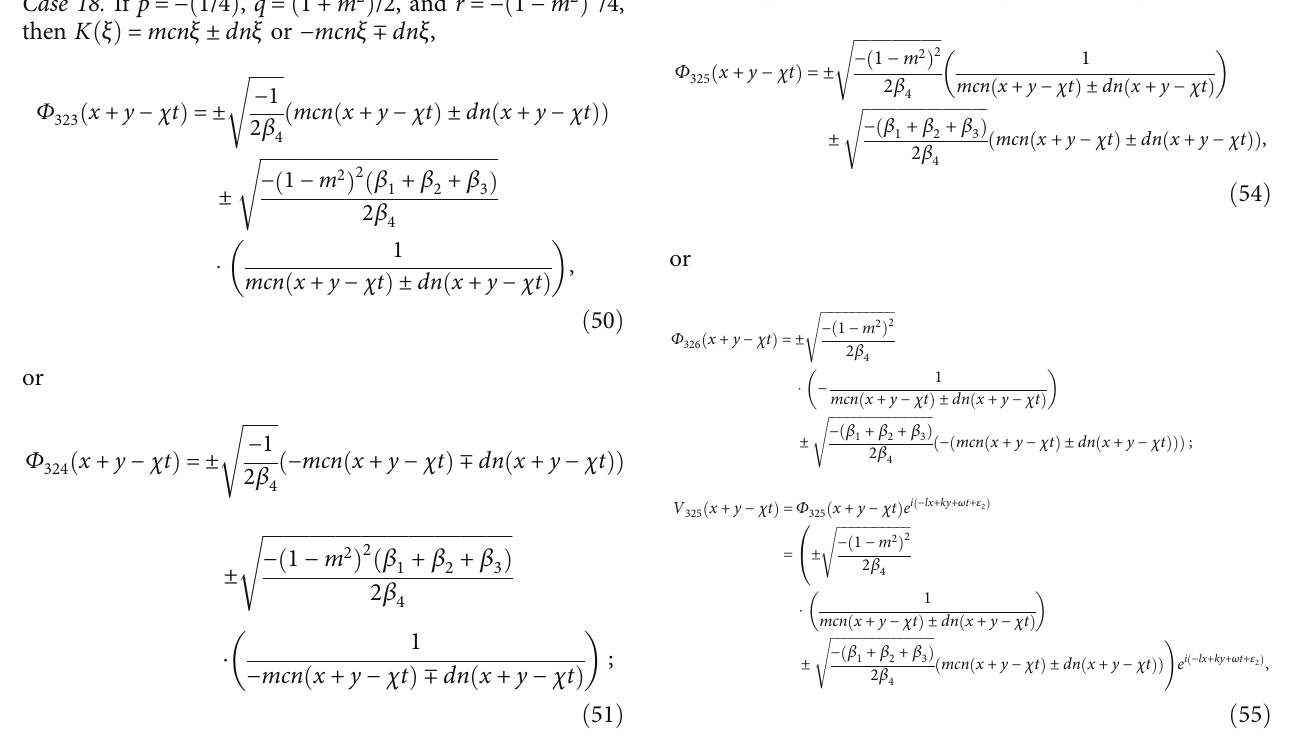
ffiffiffiffiffiffiffiffiffiffiffiffiffiffiffiffiffiffiffiffiffiffiffiffiffiffiffiffiffiffi − β 1 + β 2 + β 3